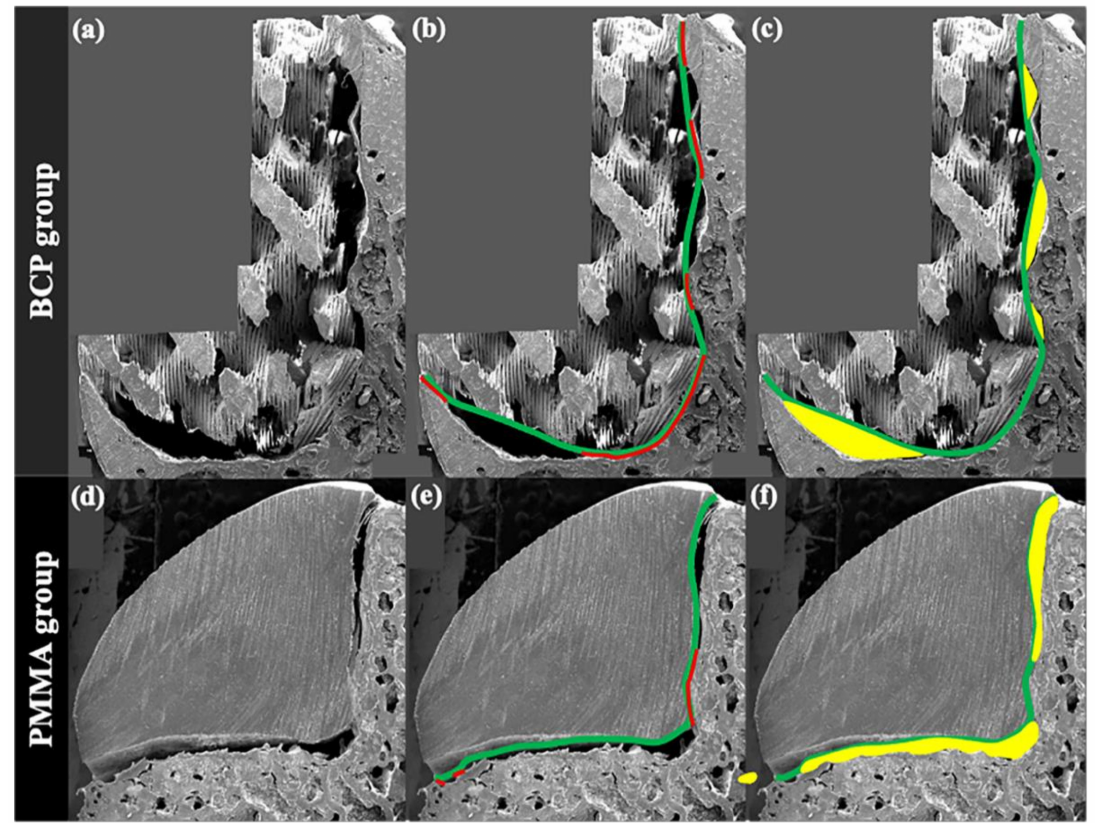
Figure 2. SEM analysis. ( a ) Biphasic calcium phosphate (BCP) block; ( b ) imaginary line (green) of connecting peaks of the BCP block and the line showing the actual contact with the defect (red); ( c ) internal gap area between imaginary line and defect (yellow); ( d ) poly methyl methacrylate (PMMA) block; ( e ) outline of the PMMA block (green) and the line showing the actual contact with the defect (red); ( f ) internal gap area between imaginary line and defect